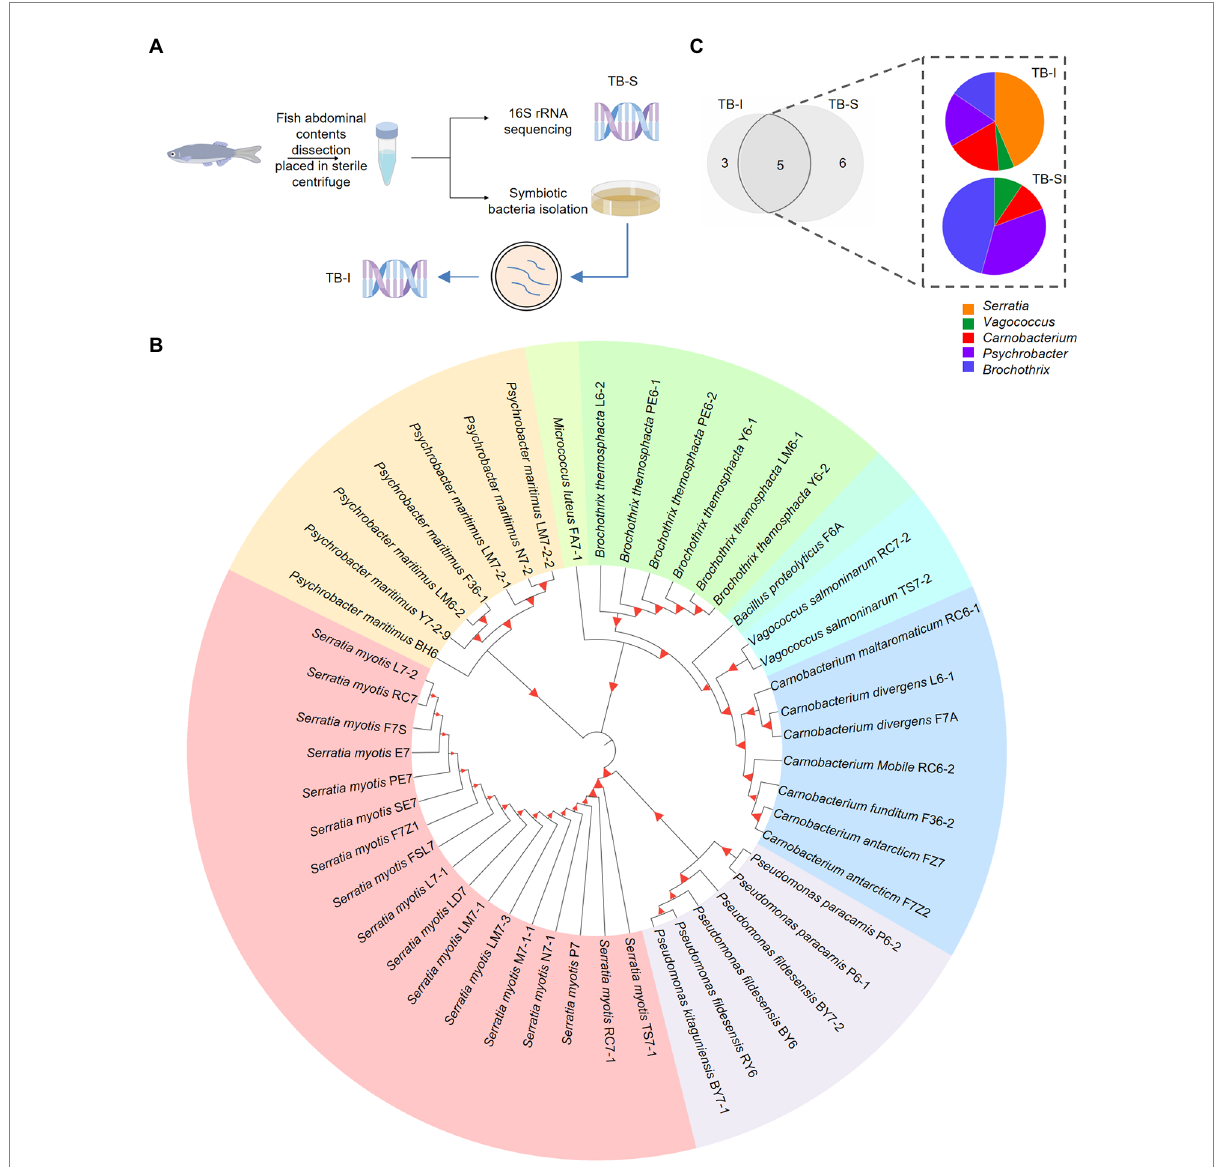
FIGURE 1 Isolation of the symbiotic Serratia bacteria of fish. (A) Workflow of the isolation and identification of symbiotic bacteria in T. bernacchii using 16S rRNA sequencing and culture method (TB-I and TB-S). www.figdraw.com. (B) Phylogenetic tree showed the kinship and composition of 47 distinct bacterial strains isolated from T. bernacchii . Itol.embl.de. (C) Composition and relative abundance of the genera shared between the two methods. Origin